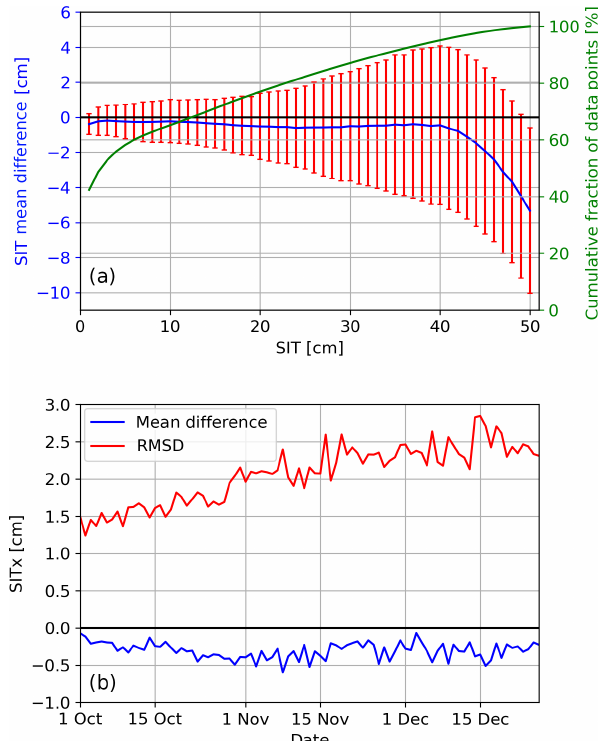
Figure 4. (a) SIT mean difference (blue) calculated by subtract- ing the SIT computed using 40–50 ◦ daily average from SIT us- ing TBs fitted at 45 ◦ for the 1 October to 26 December 2010 pe- riod. The mean difference is computed relative to the daily average SIT in bins of 1cm and its corresponding RMSD (red). The green curve represents the fraction from the total amount of data points for each thickness bin. Panel (b) shows the mean difference (blue) and RMSD (red) for each day separately.